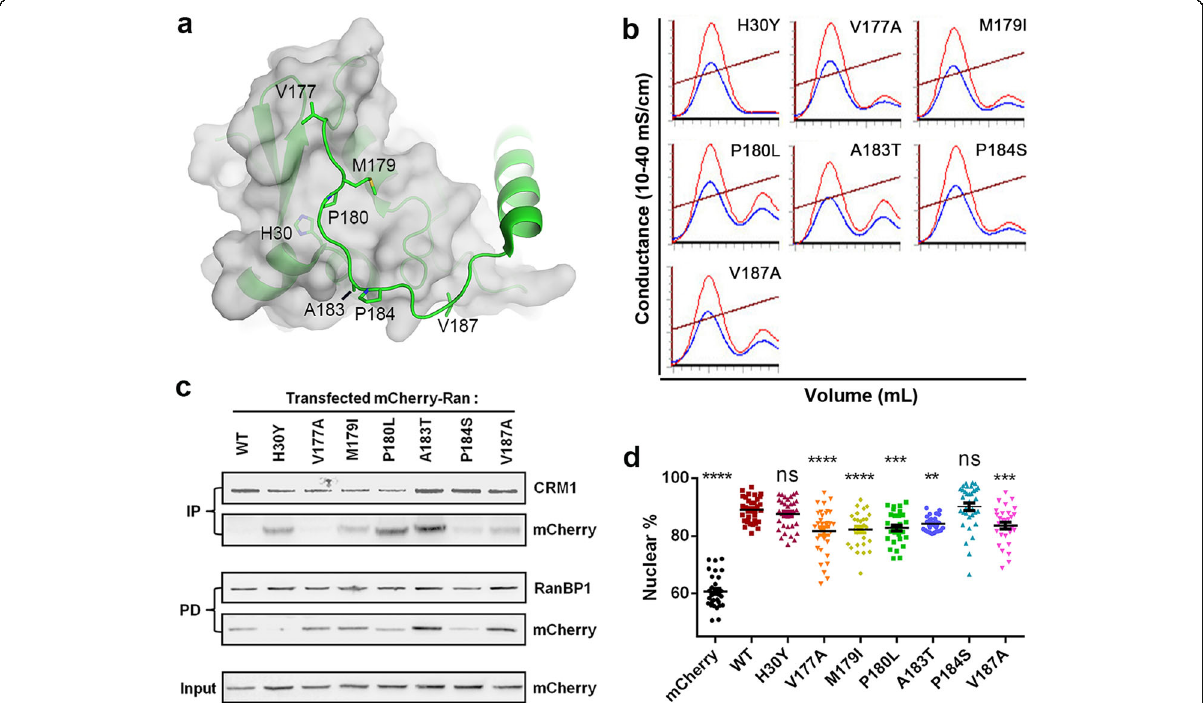
Fig. 5 Discovery of multiple C-dis Ran mutants in cancers. a Location of mutated residues (stick) in cancers on the RanGDP crystal structure (3GJ0). Ran is displayed as a green cartoon with G-domain covered in partially transparent grey surface. b GTP% quantification by Q analysis for freshly purified cancer mutants. The brown line represents conductance. A260 and A280 are shown as red and blue curve, respectively. The peaks on the left and right represent GDP and GTP peaks, respectively. c CRM1 immunoprecipitation and GST-RanBP1 pull-down of transfected mCherry-Ran mutants in 293 T cells. d Subcellular localization of Ran cancer mutants. Error bars represents standard error of measurement (SEM). The statistical significance with Ran WT sample is indicated at the